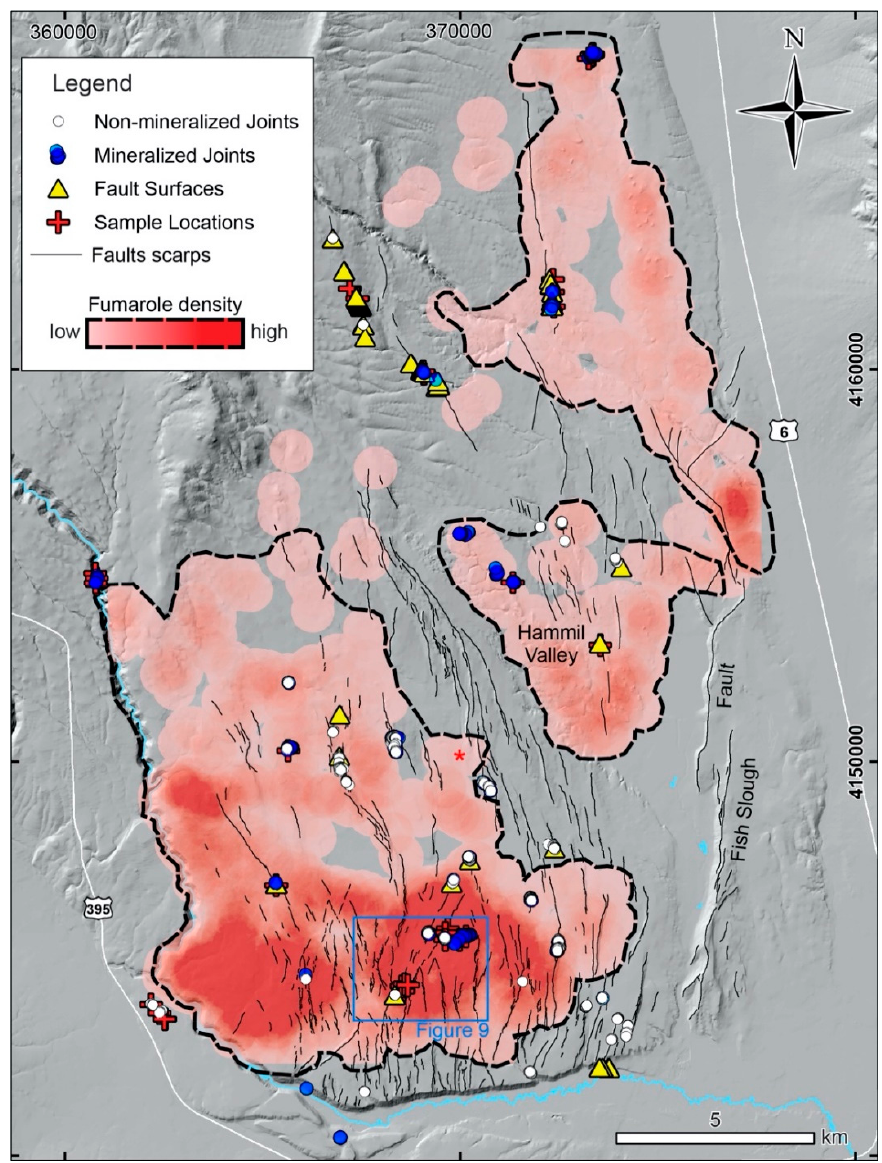
Figure 2. Hillshade map showing the locations and type of field observations described in this study with respect to mapped fault scarps. The areas shaded in red are the calculated point density with a sample radius of 500 m of 2164 mapped fumarolic mounds, with gradational shading to represent a count of <10 (low) to >50 (high) fumaroles per 1 km 2 . We outline three zones of high fumarole density with a thick dashed line for reference in Figure 11a. UTM coordinates are given in meters for UTM zone 11N.